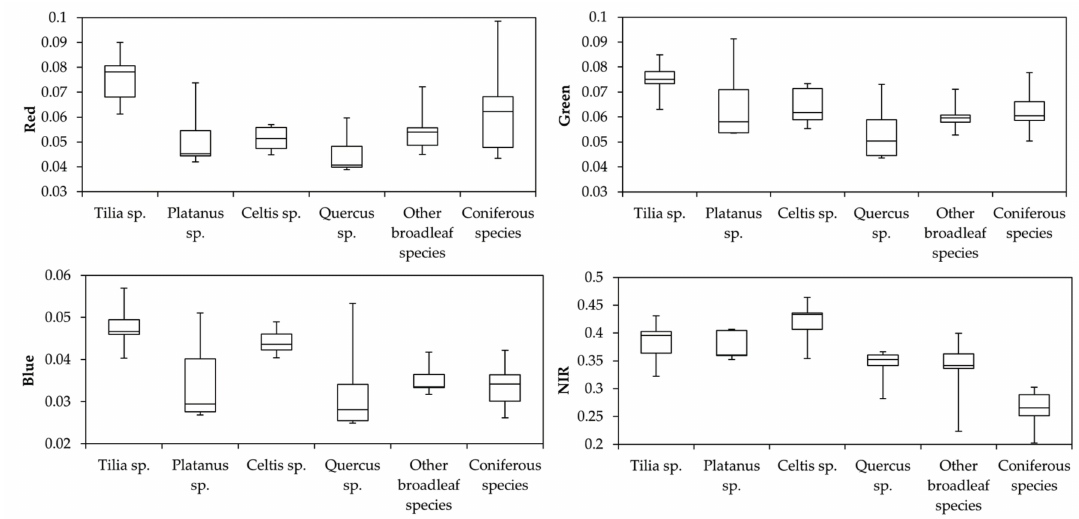
Figure 3. Mean spectral values within each of the summer Pl é iades image spectral bands of the six classes over the study